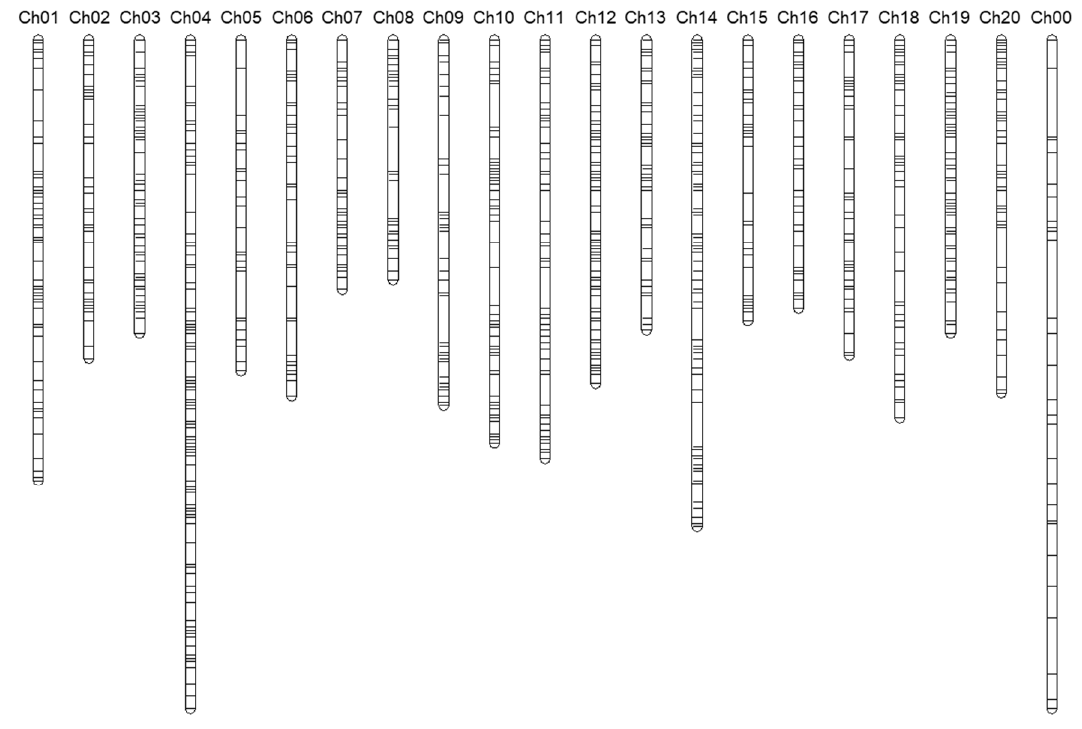
Figure 1. The genome-wide SNP distribution (2,071 SNPs) in the C. moschata chromosomes.